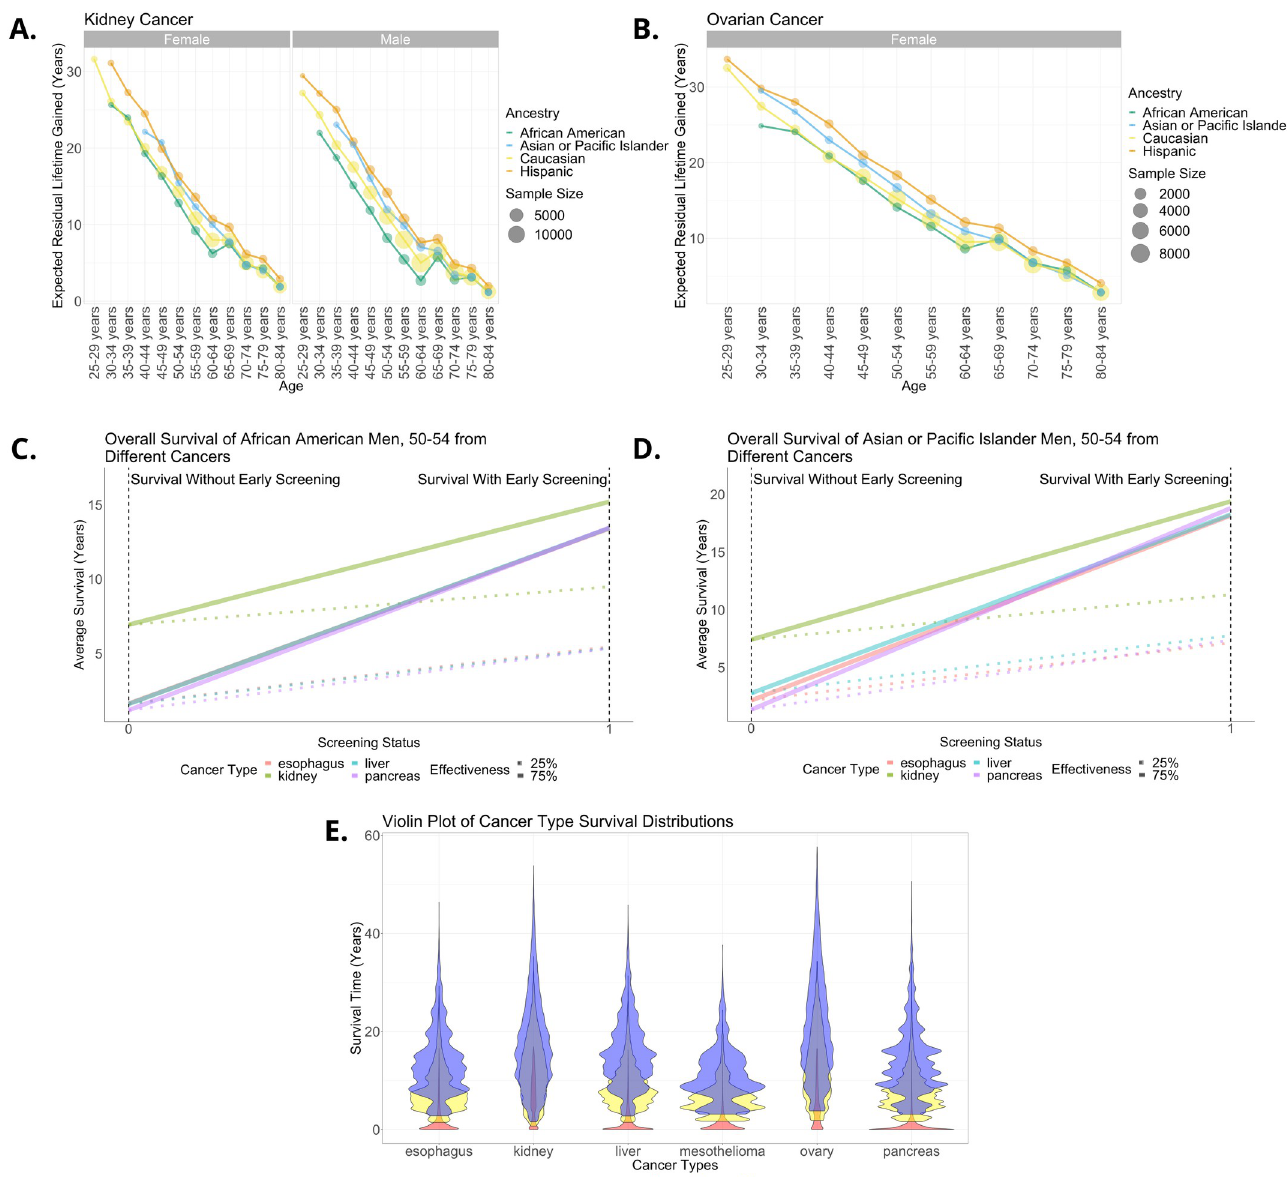
Fig 4. Overall predicted survival benefits of putative screening programs for a variety of cancer types for which there are currently no widespread screening technologies and a cross cancer comparison. (A) Overall predicted survival benefit from a potential kidney cancer screen of 75% effectiveness stratified by age, sex and ancestry. There is an artificial bump at age 65 due to the discrete stratification of conditional lifetime distributions (Materials and Methods). (B) Analogous plot for a potential ovarian cancer screen under the same assumptions. The sample size used to estimate the parameters is given by the point size. Higher sample sizes yield more reliable estimates, so where the sample size is less than 100 subjects, we do not make an estimate. Since this disease only affects females, males are not included. (C) Comparison of the change in overall survival as a result of screening for different cancer types for African American men aged 50–54. Survival without screening is shown on the left-hand side and the predicted survival with screening is on the right. We display two scenarios: one in which screening has an effectiveness of 25% and another with effectiveness of 75%. (D) The analogous slope chart for Asian or Pacific Islander men of the same age. (E) Violin plot showing the survival time distribution of cancer patients by type under three different scenarios. The first (in red) is based on the SEER data and is the observed survival distribution. Then we present two modeled screening scenarios: one in which effectiveness post detection is 50% (yellow) and another where it is 100%